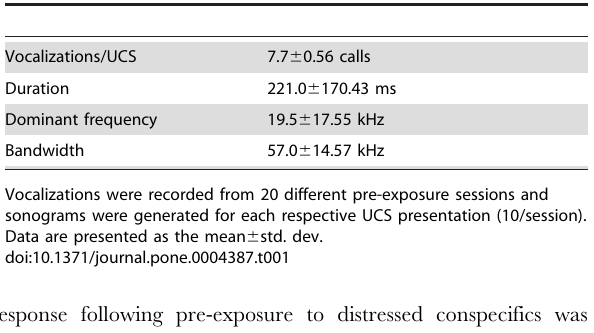
Table 1. Descriptive statistics for object distress vocalizations.